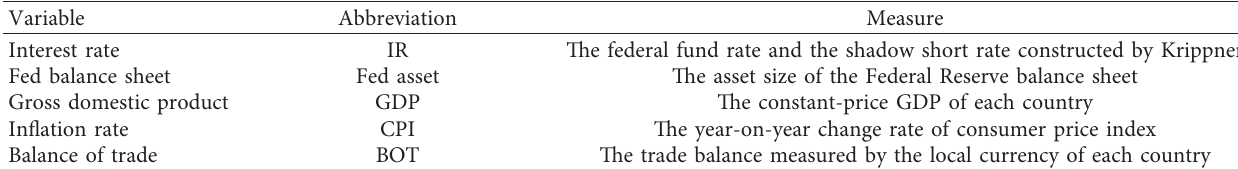
Table 1: Description of the